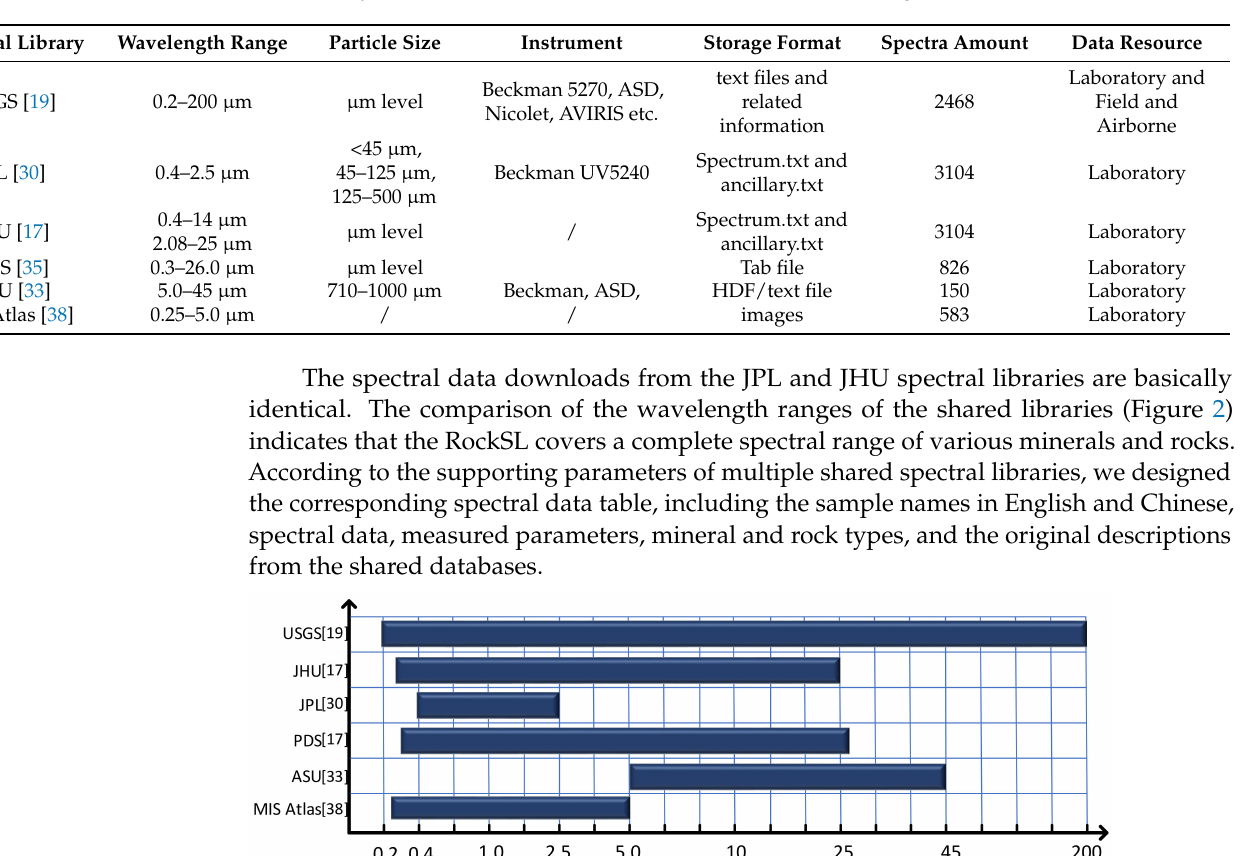
Table 1. Key measurement information of the shared libraries integrated in RockSL.